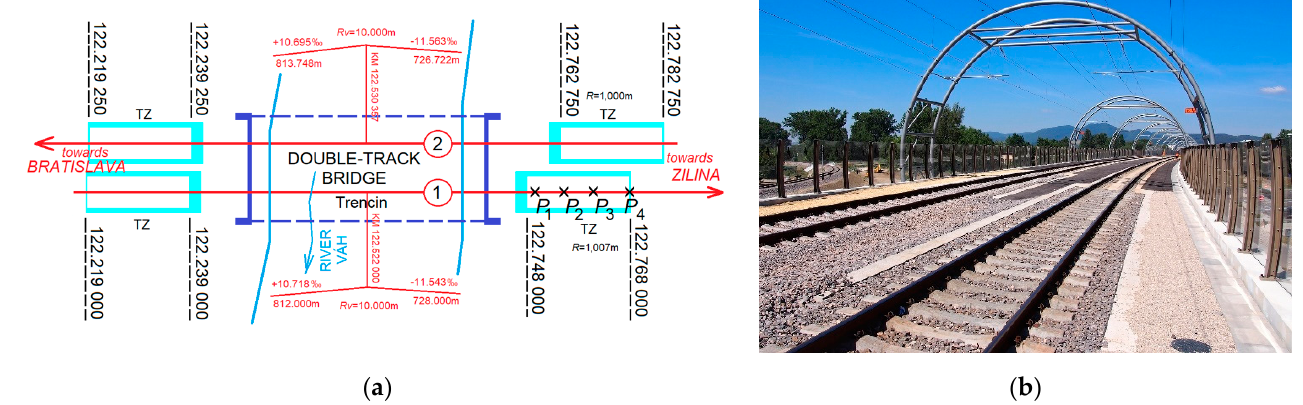
Figure 6. Railway double-track bridge in Trencin V = 140 km/h: ( a ) Scheme of TZ; ( b ) Photo: Transition zones—ballasted track to bridge with a fixed track [13,16].